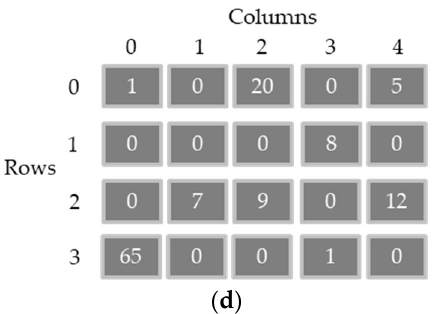
Figure 5. Examples of sparse arrays: ( a ) Sparse vector; ( b ) Relevant values of the sparse vector; ( c ) Column positions, followed by the valid value for them; ( d ) Sparse matrix.